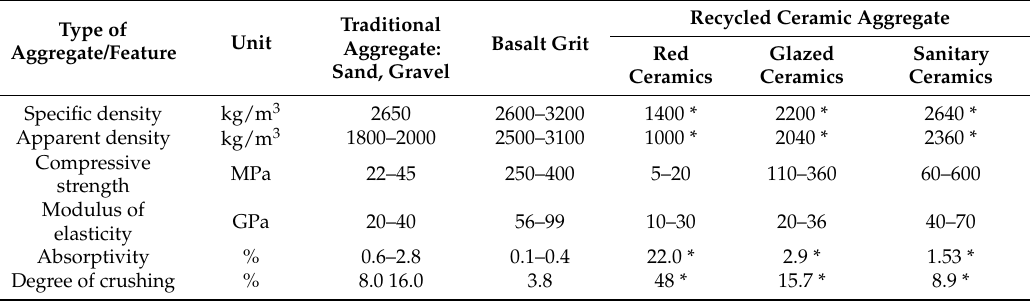
Table 6. Ceramic aggregate features compared to other aggregates used in concrete [52]. (*—Data from the authors’ own research).